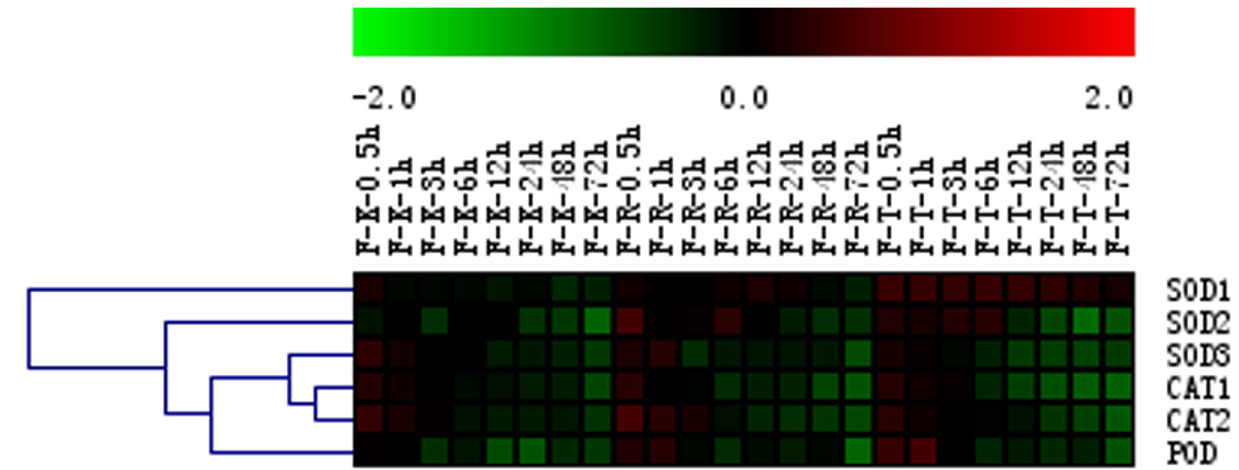
Figure 5. Hierarchical clustering of antioxidant gene expression in the flowers of three grape cultivars following GA treatment. Results of semi-quantitative RT-PCR assays were quantified using GeneTools software, and log-transformed values of the relative expression levels of genes encoding antioxidant enzymes following GA used for hierarchical cluster analysis. The color scale represents relative expression levels with red denoting up-regulation and green denoting down-regulation. Sampling times are indicated at the top of the figure; F represents floral tissue; K represents the ‘Kyoho’ cultivar; R represents the ‘Red Globe’ cultivar; T represents the ‘Thompson seedless’ cultivar.